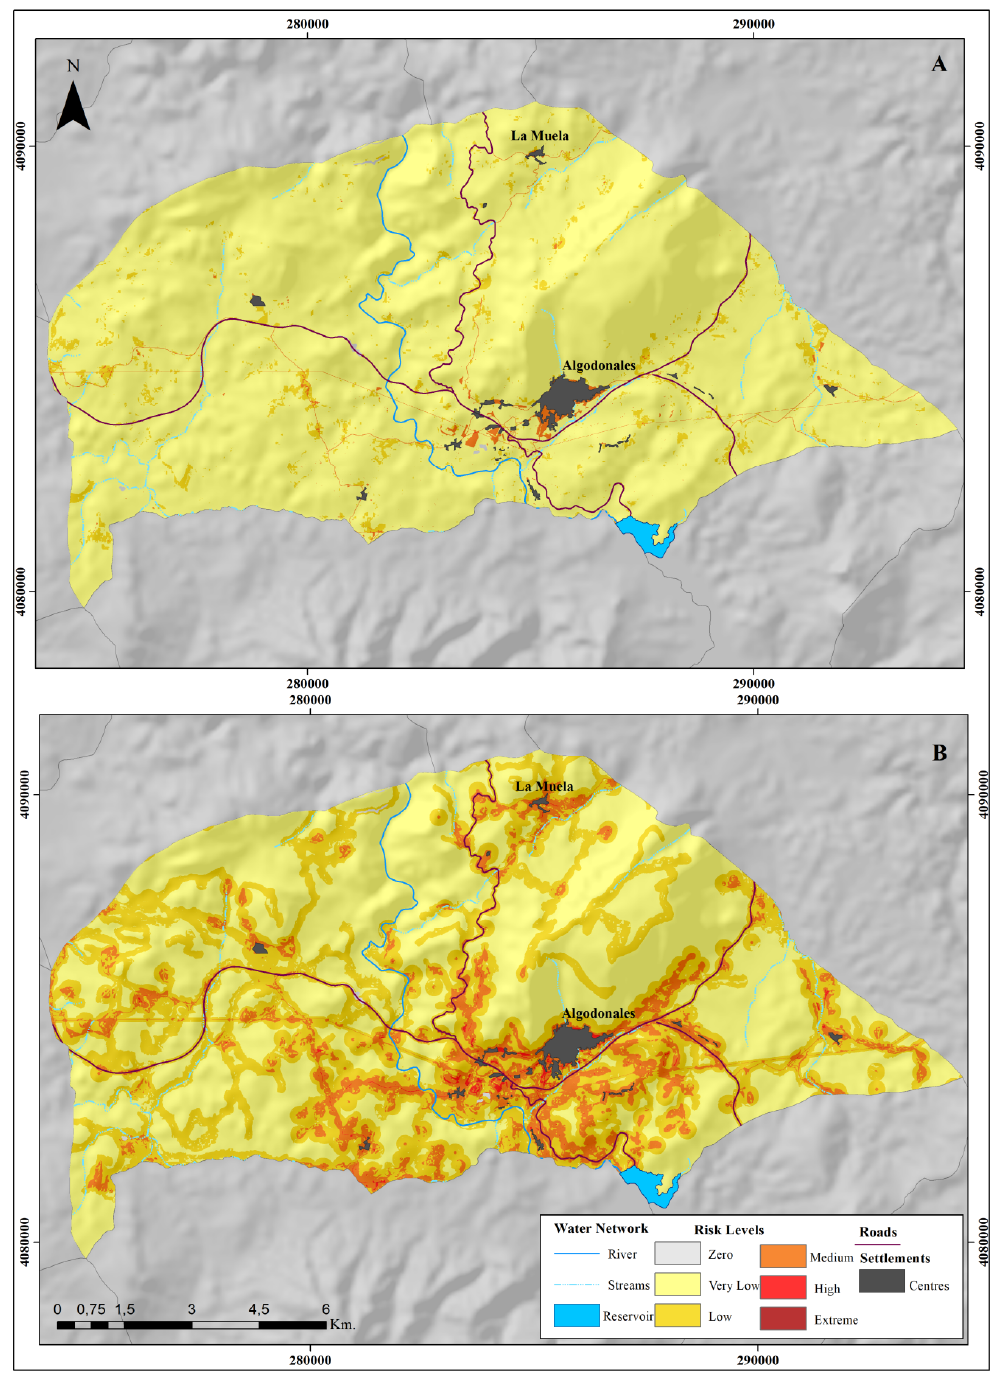
Figure 11. Short Terms Risk maps. ( A ) 14 January 2013. ( B ) 25 July 2013.